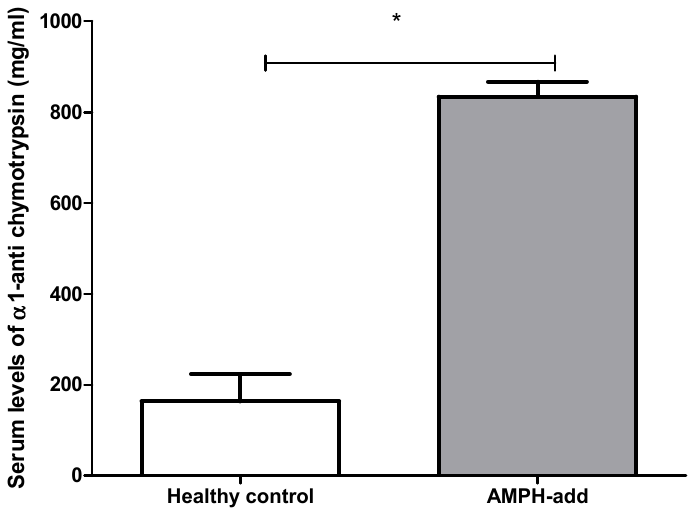
Figure 1. Comparison of α 1-antichymotrypsin serum level between AMPH-add and control. Data are expressed as mean ± standard error. Statistical analysis was carried out using unpaired Student’s t -test. *: statistically significant at p < 0.05.